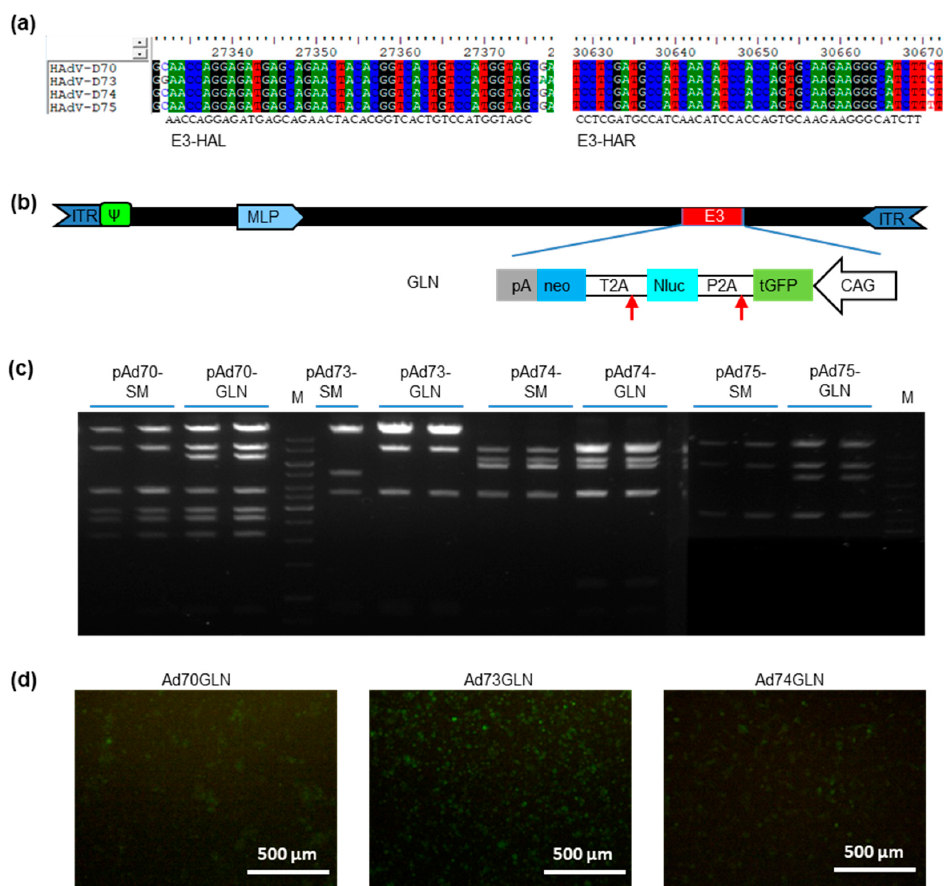
Figure 4. High-throughput reporter insertion in new species D human adenovirus (HAdV-D). ( a ) Identification of conserved sequences in the adenovirus early gene 3 (E3). Genome sequences of four new HAdV-Ds (Ad70, Ad73, Ad74, and Ad75) were analyzed by ClustalW Multiple alignment in BioEdit Sequence Alignment Editor, the conserved sequences on the left and right end of E3 was used as homologous arm (E3-HAL and E3-HAR) for reporter insertion. ( b ) Diagram shows the GLN reporter cassette insertion into the E3 genomic region. GLN reporter cassette expresses turbo Green fluorescent protein (GFP), nanoLuciferase (Nluc), and neomycin resistance (neo) under the control of the CAG promoter (CMV enhancer, chicken beta-Actin promoter, and rabbit beta-Globin splice acceptor site). ( c ) AhdI restriction check of the reporter insertion. SM, selection marker used for